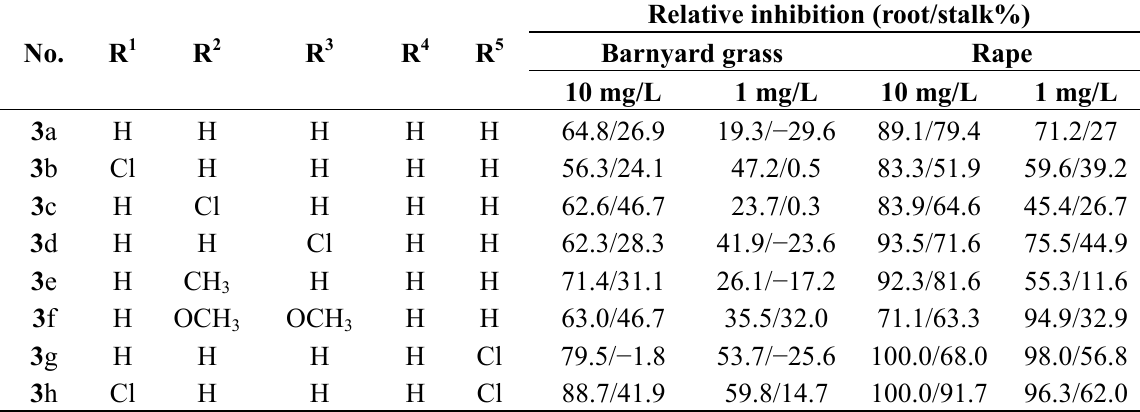
Table 1. The percent inhibitory ratios against the growth of root and stalk of